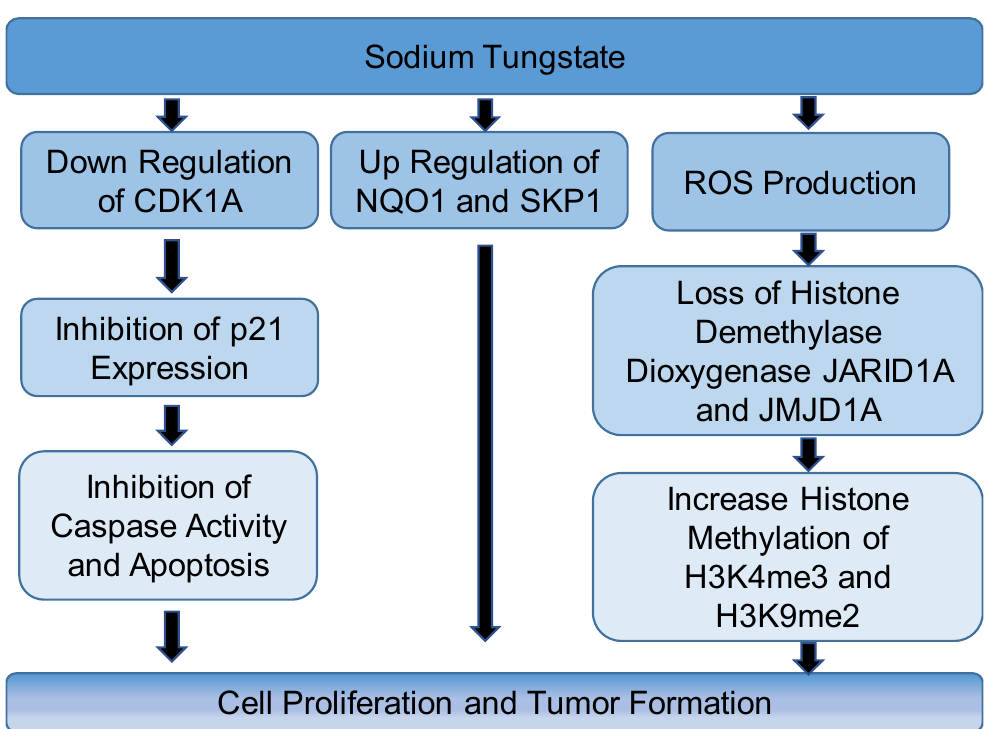
Figure 1. Summary of the proposed mechanisms of sodium tungstate toxicity. CDK1A: cyclin-dependent kinase inhibitor 1A; JARID1A: Jumonji-AT rich interactive domain 1A; JMJD1A: Jumonji domain containing 1A; NQO1: NADPH dehydrogenase quinone 1; ROS: reactive oxygen